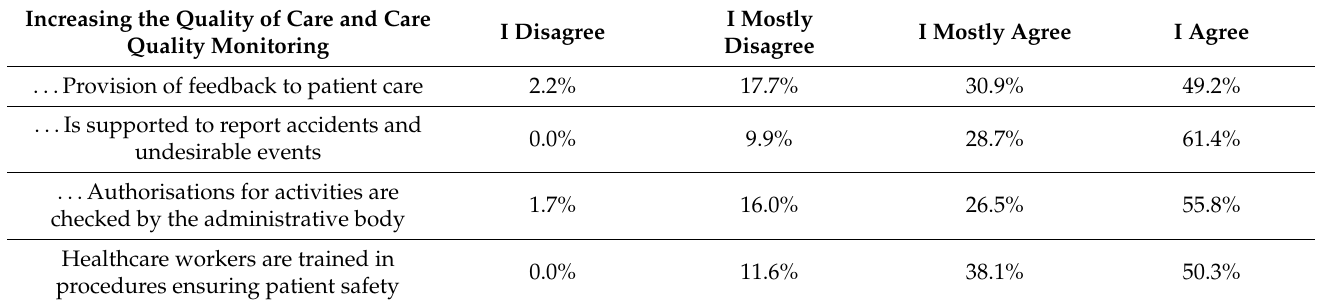
Table 4. Responses to items related to “increasing the quality of care and care quality monitoring”.